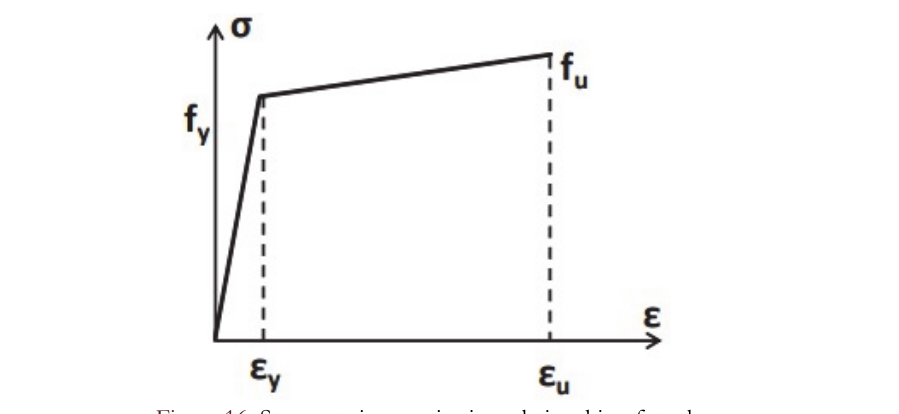
Figure 16: Stress-strain constitutive relationship of